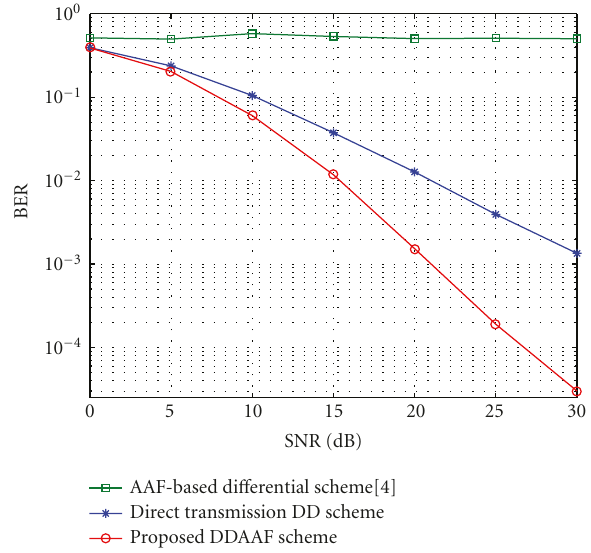
Figure 4: Comparison of BER versus SNR performance of DDAAF cooperative system with conventional